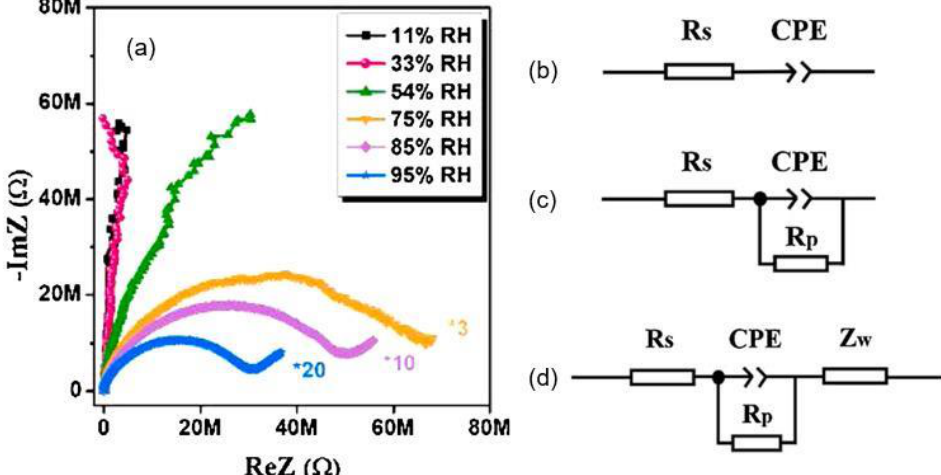
Figure 14. ( a ) The complex impedance spectroscopy plots of blank paper at different RHs. ( b – d ) The corresponding equivalent circuits. CPE- constant phase element; R p - equivalent film resistance; Z w - Warburg impedance. Reprinted with permission from [217]. Copyright 2021: Elsevier.